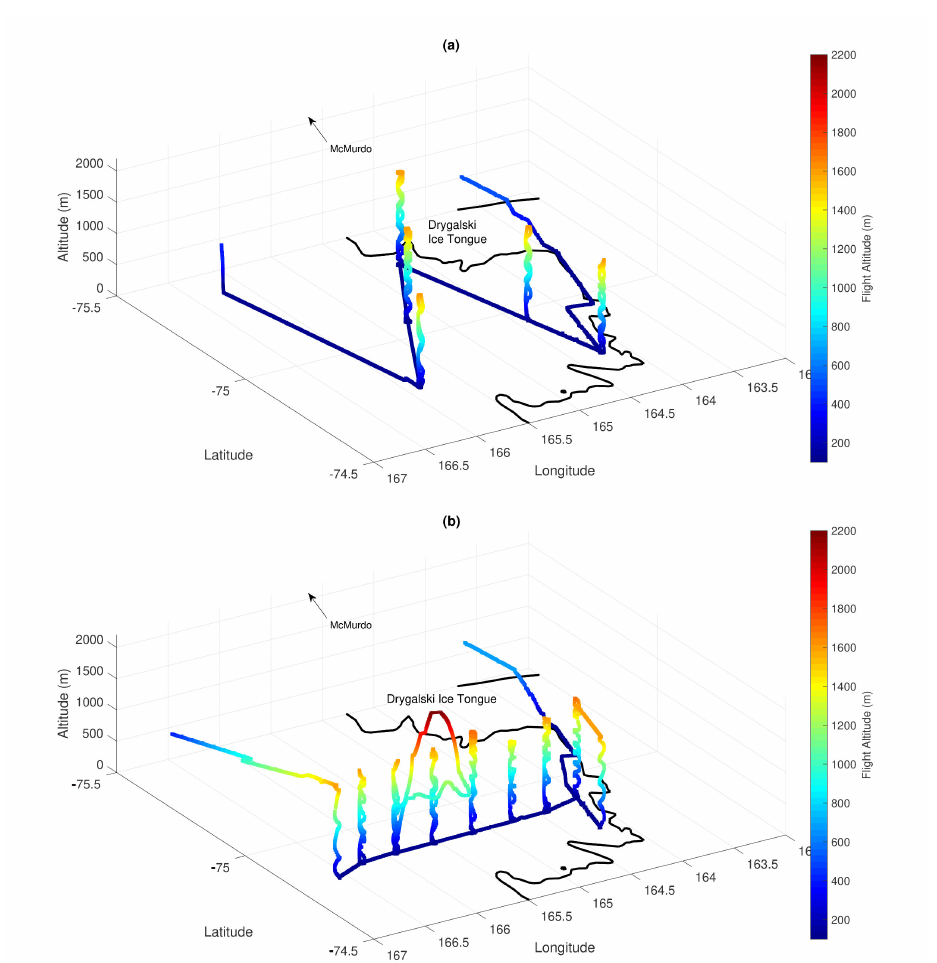
Figure 2. UAS Aerosonde crosswind ( a ) and transect ( b ) flights on the 25 September